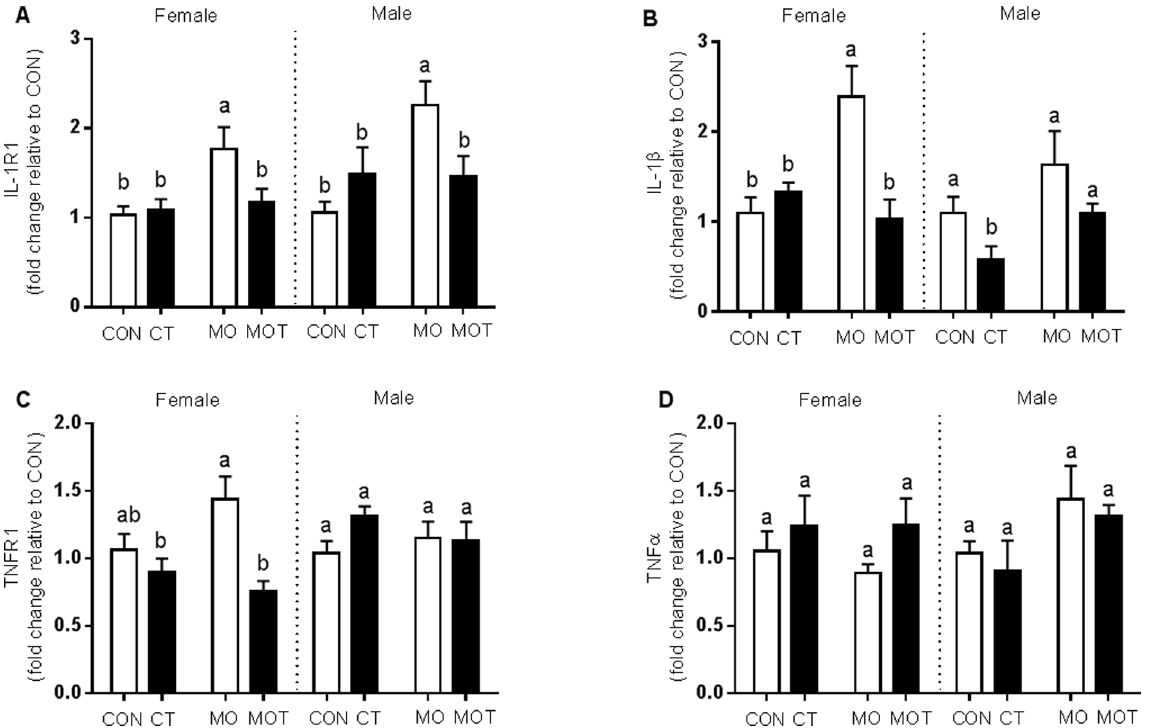
Figure 6. Neonatal liver inflammatory gene expression. Neonatal hepatic gene expression of (a) IL-1R1; (b) IL-1 b ; (c) TNFR1 and (d) TNF- a . Lower case letter superscripts ( a,b,c ) indicate multiple comparison procedures were conducted for diet and taurine interaction. Groups that do not share the same letter are significantly different from each other (p , 0.05). Data are means 6 SEM, n=7–9 per group.